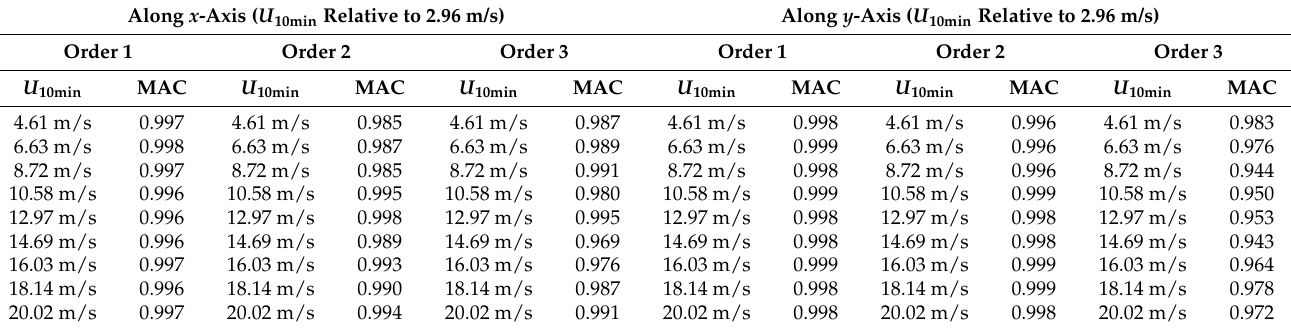
mode shape vector along x and y axes are all appear on the 24th floor. The maximum deviations of mode shape vectors at the first order along x and y axes are 0.10 and 0.08, respectively, and those at the second order are 0.25 and 0.15, and those at the third order